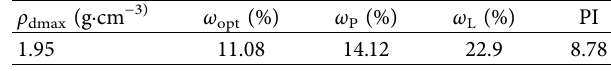
Table 1: Index properties of the experimental soil.